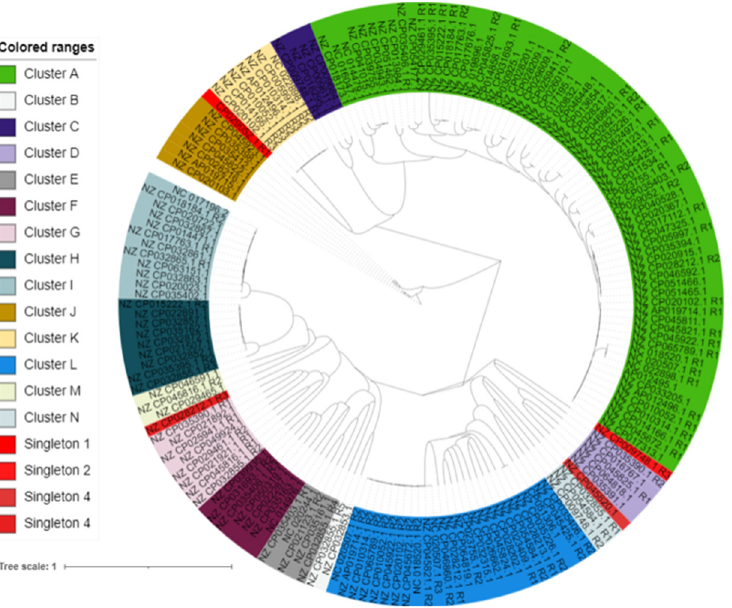
Figure 5. Phylogenomic relationships of B. subtilis IPs. The distances of the IP sequence were calculated using Gegenees. Then, the tree was constructed by SplitsTree4 and visualized by iTOL. Clusters are coded by different colors, and singletons are in red.